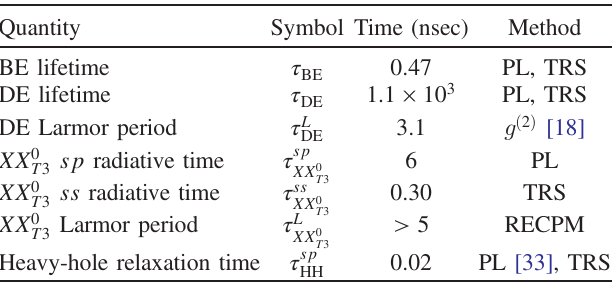
DE- XX 0 optical transition at 1.294 eV [green arrows in T (cid:1) 3